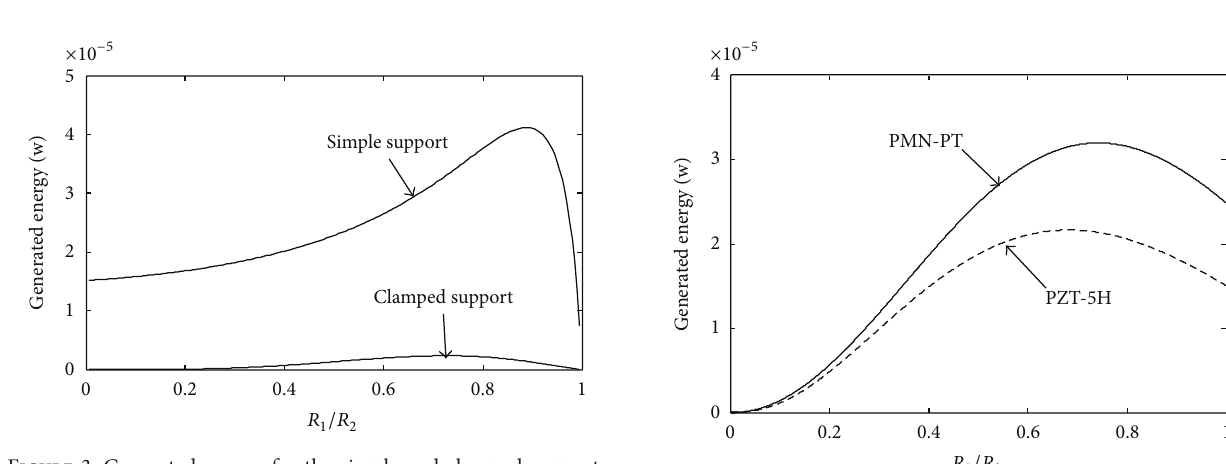
Figure 3: Generated energy for the simple and clamped supports according to the variations of piezoelectric plate radius ( 𝑅 2 = 20 mm) (Sections 2.3 and 2.4).